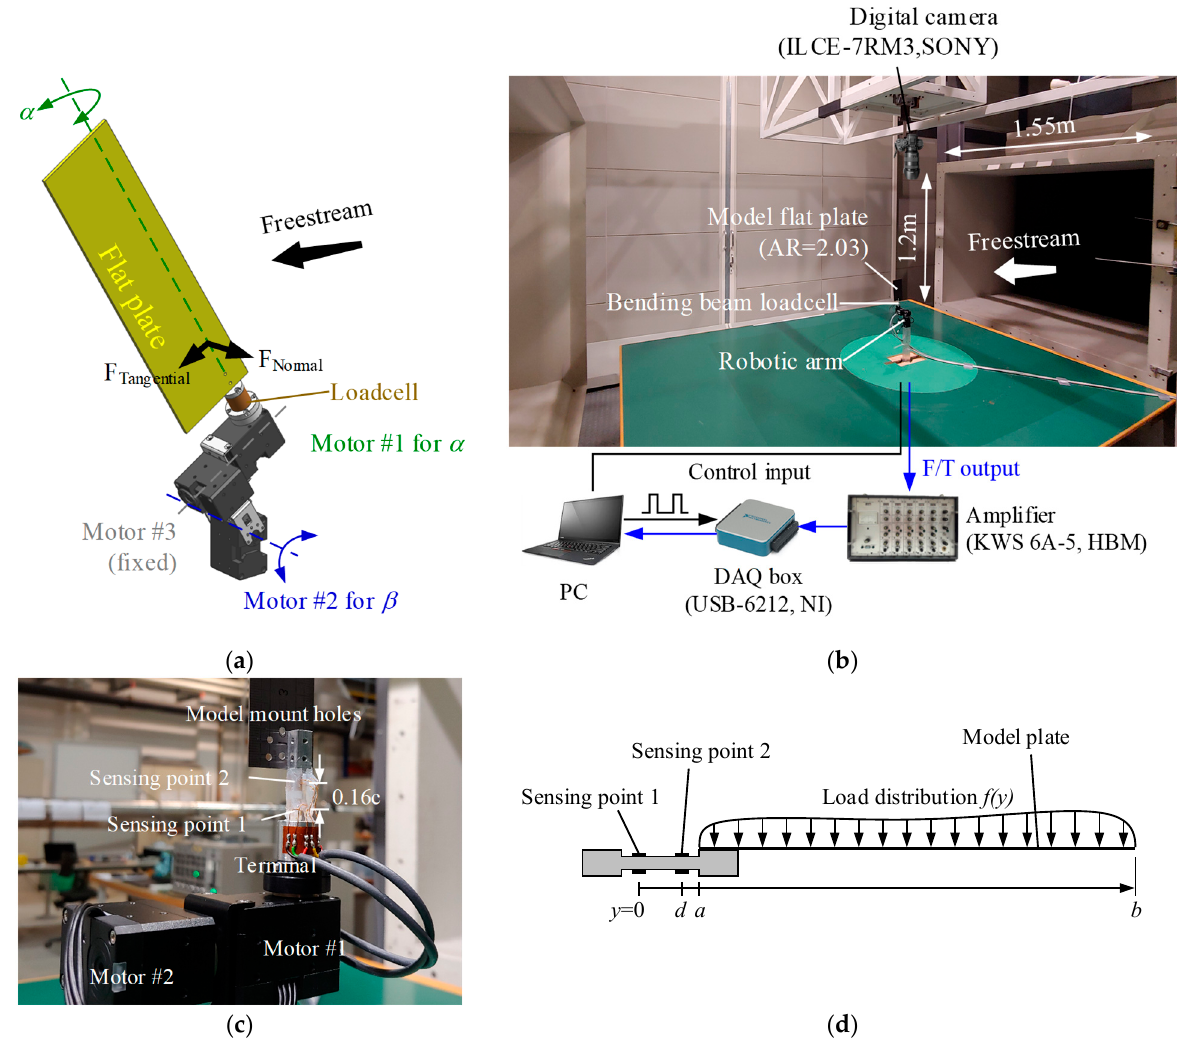
Figure 1. Experimental setup. ( a ) A robotic arm consisting of three servo motors; ( b ) The test setup in the wind tunnel B at the Technical University of Munich; ( c ) The gram-scale force/moment bending-beam loadcell; ( d ) A relation of the measured moments and force on the loadcell.